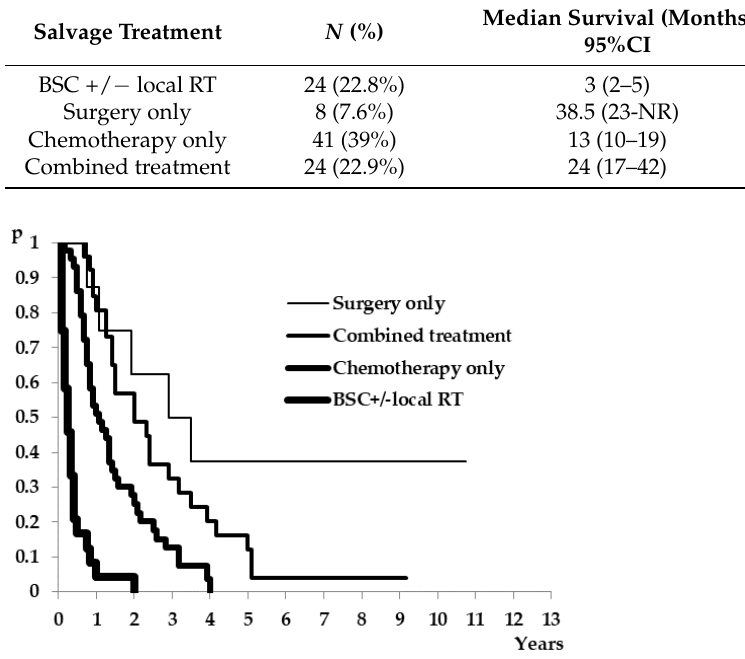
Figure 3. Kaplan – Meier curves for post-recurrence survival according to salvage treatments. Figure 3. Kaplan–Meier curves for post-recurrence survival according to salvage